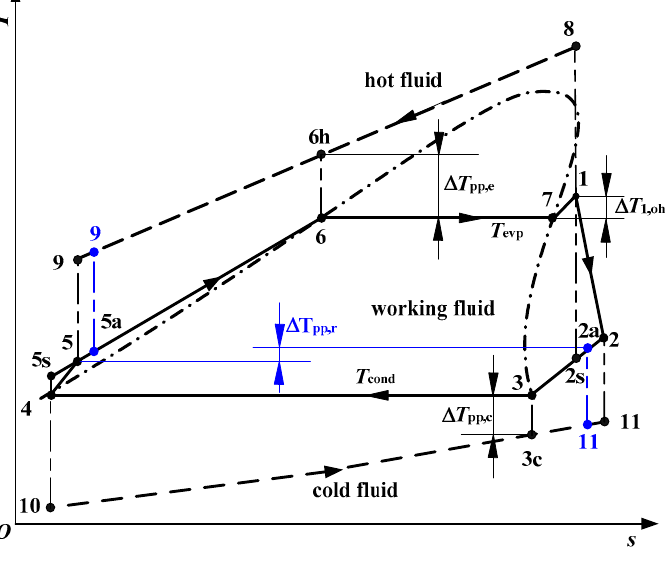
Figure 2. T - s diagram of non-regenerative/regenerative ORC systems.